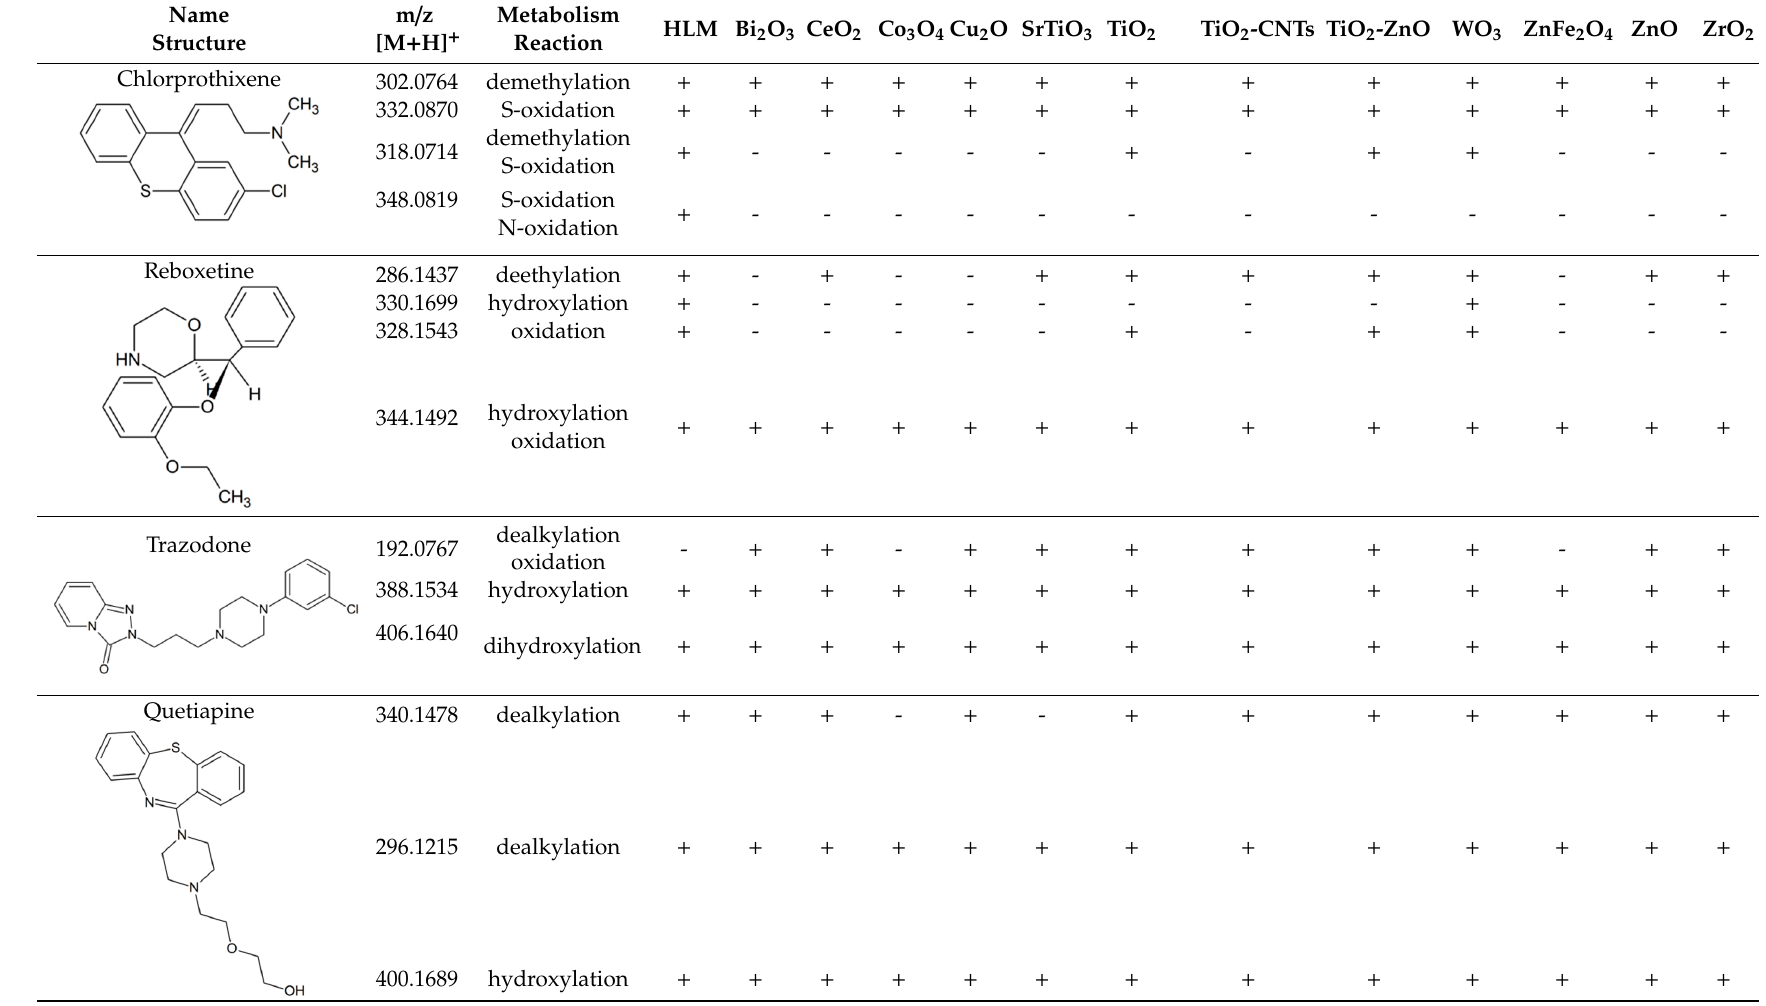
Table 1. Metabolites observed during HLM incubation and photocatalytic experiments.